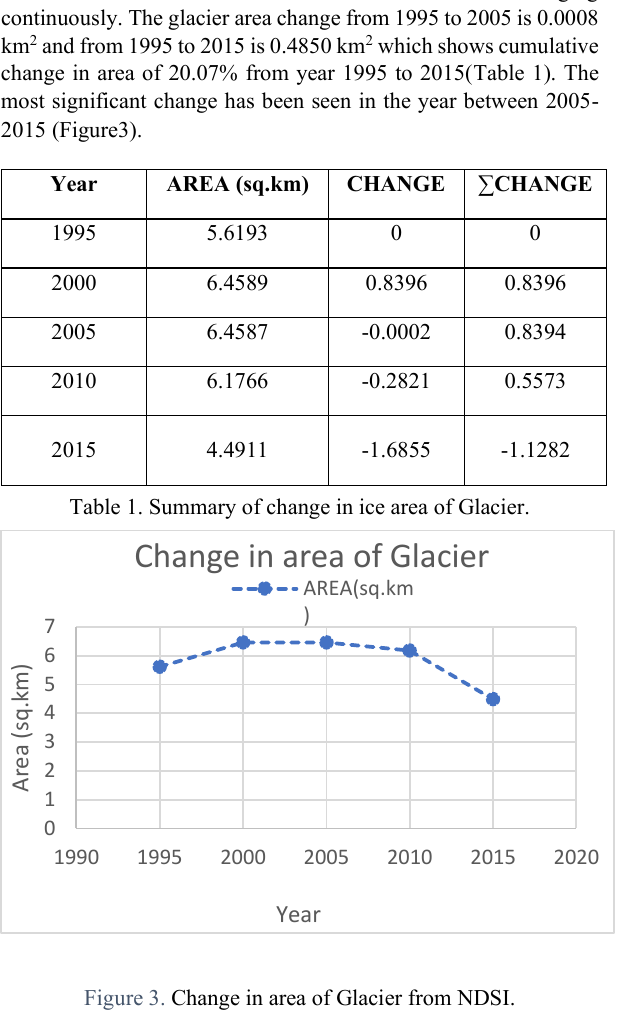
Figure 3. Change in area of Glacier from NDSI.